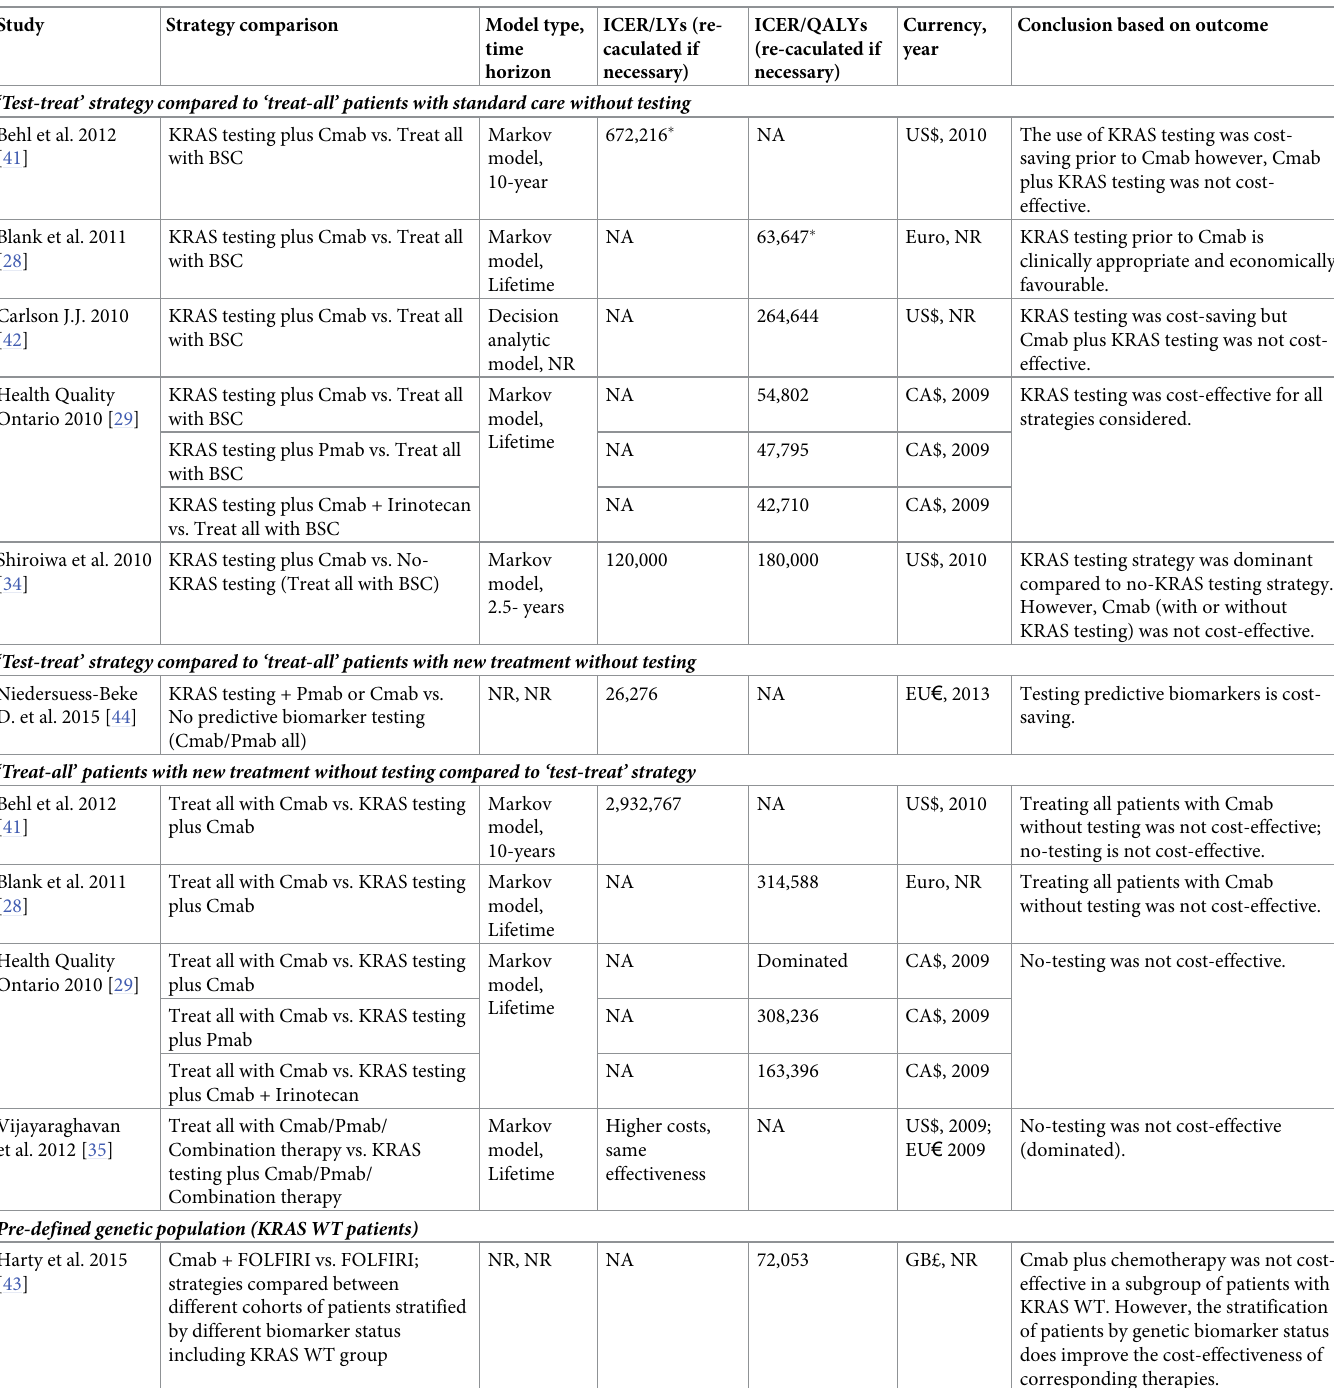
Table 1. Cost-effectiveness finding of KRAS testing for corresponding targeted therapies.